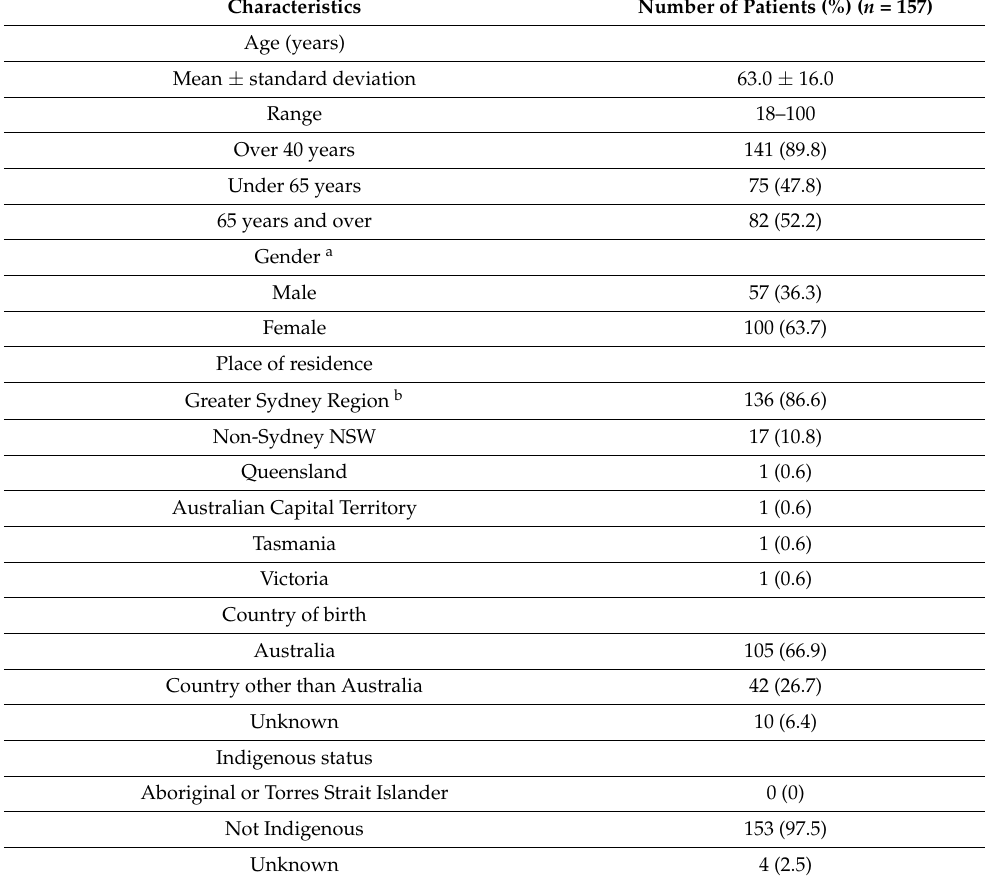
Table 1. Clinical characteristics of adults prescribed medicinal cannabis at the